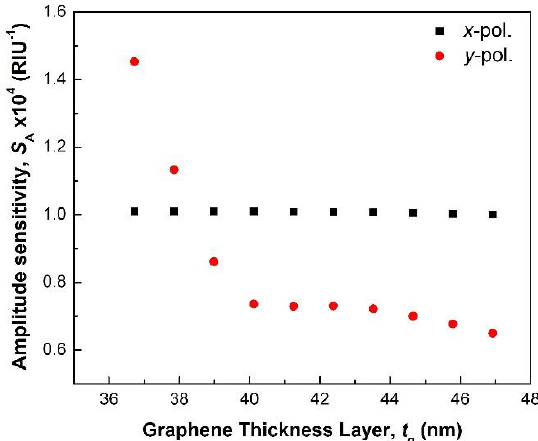
Figure 8. Amplitude sensitivity as a function of graphene layer thickness. Black points (square